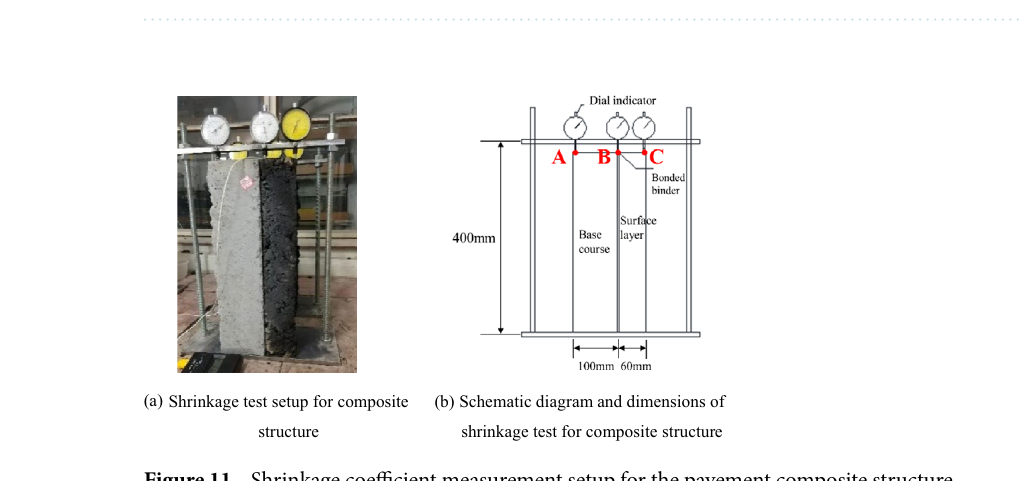
Figure 10. Temperature shrinkage coefficients of asphalt concrete.